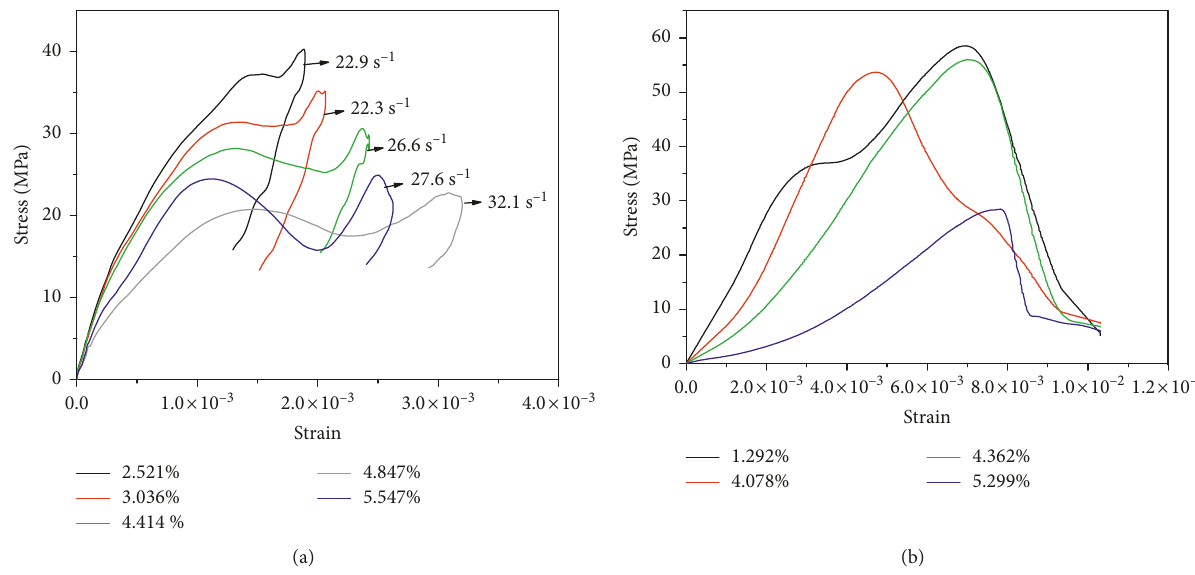
Figure 8: Curve of stress and strain for uniaxial compression of weakly weathered granites with different porosities. (a) High strain rate. (b)